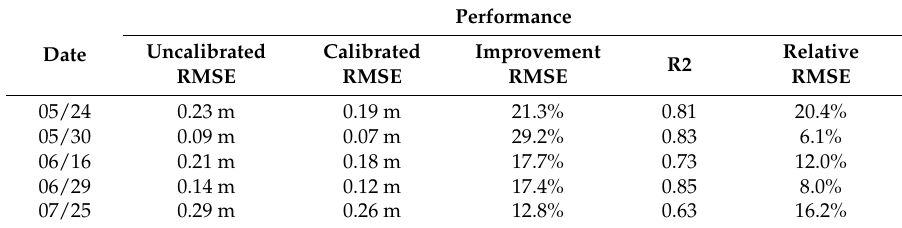
Figure 17. Comparison of uncalibrated data and calibrated data through the height calibration method over five flights on ( a ) 05/24, ( b ) 05/30, ( c ) 06/16, ( d ) 06/29, and ( e ) 07/25. The black dotted line indicates a 1:1 ground truth line. Table 7. Accuracy improvement results between uncalibrated data and calibrated data from the height calibration method over five flights.